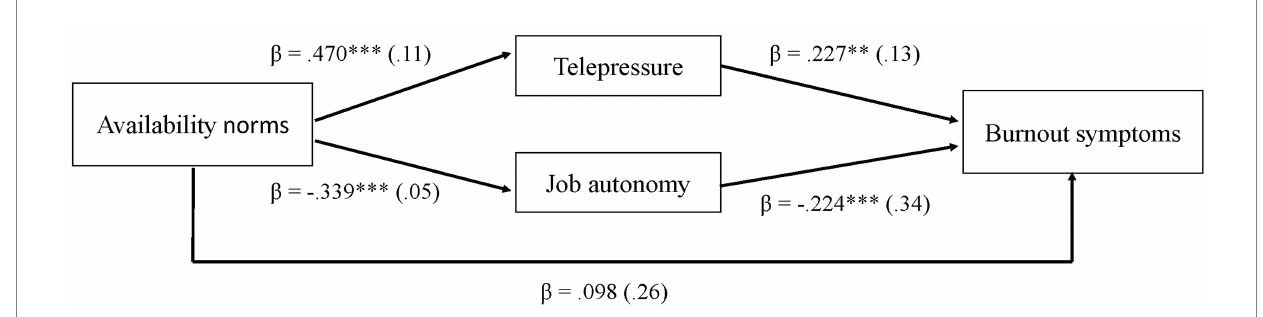
FIGURE 2 Mediation model for telepressure and job autonomy. Standard errors in parentheses. * p < 0.05; ** p < 0.01; *** p <